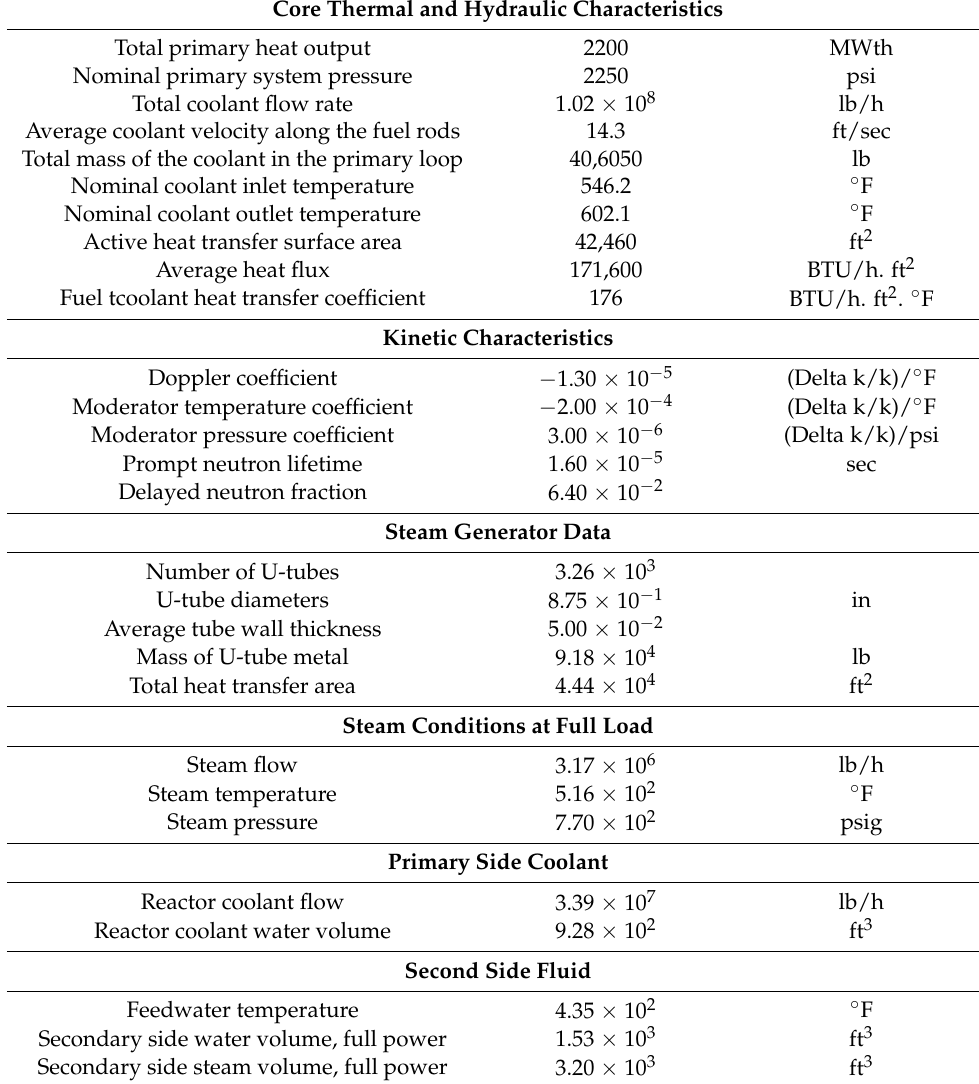
Table 2. PWR reactor specifications